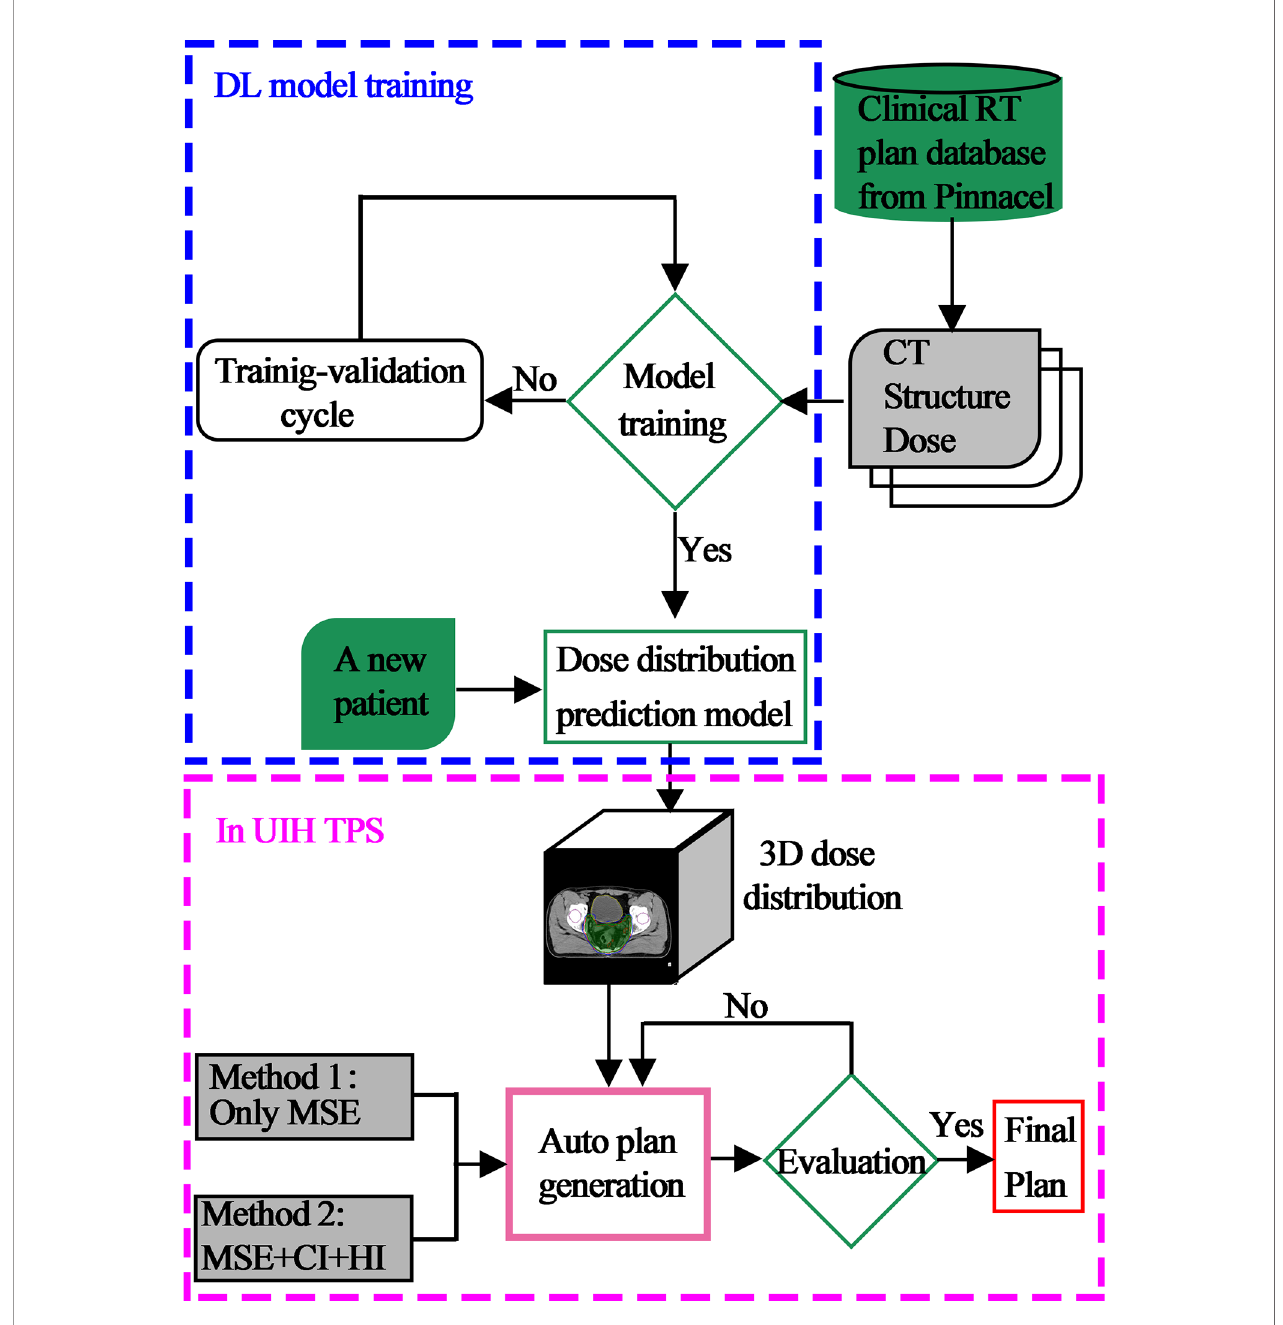
FIGURE 2 | Overview of the automated treatment planning work fl